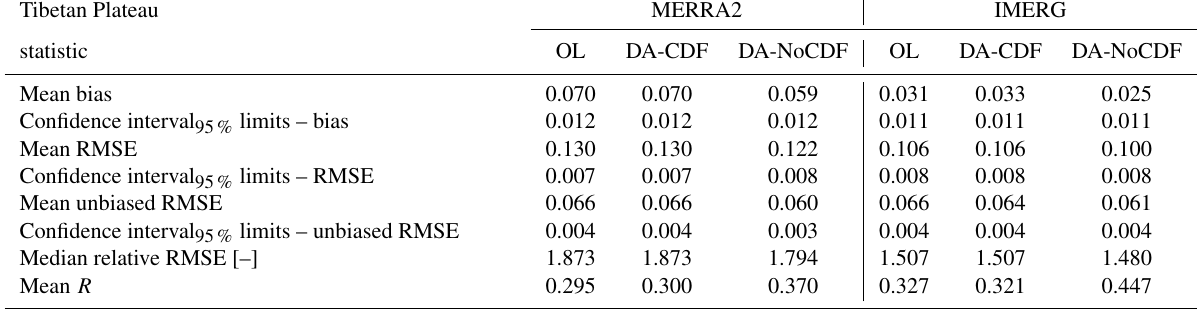
Table 2. Statistics of OL and DA soil moisture estimates (2015 to 2020) computed with respect to the soil moisture measurements across the Tibetan Plateau. All values are in units of cubic meter per cubic meter (m 3 m − 3 ) unless otherwise indicated. Mean refers to the average of all the stations included within the network. OL is open loop, DA-CDF is CDF-matched SMAP retrieval assimilation, and DA-NoCDF is data-assimilated estimates without CDF matching.